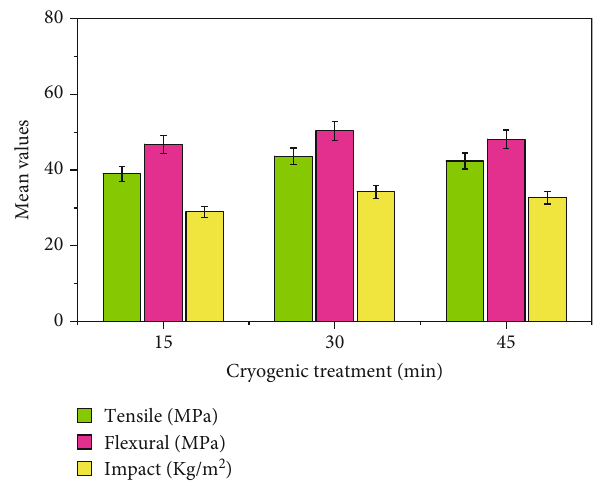
Figure 6: Mean values of tension, bending, and impactness of hybrid composites based on cryogenic